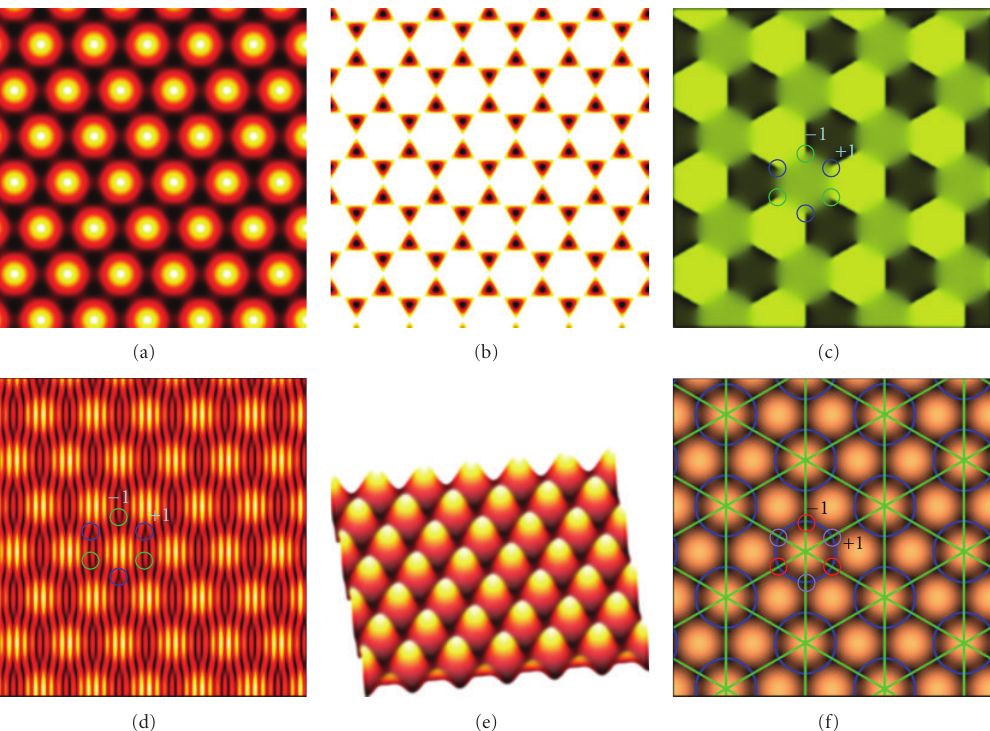
Figure 1: Analysis of three noncoplanar beam interference patterns possessing a distribution of single-charged vortices. (a) Intensity distribution in x - y plane. (b) Intensity distribution with a lower threshold value in order to highlight the darker regions alone. (c) Phase profile. (d) The fork formation while the pattern is interfered with a plane wave launched at a large angle from the axis. (e) Intensity mesh plot. (f) Zero crossing plot (blue line: zeros of Re E ( r ) and green line: zeros of Im E ( r